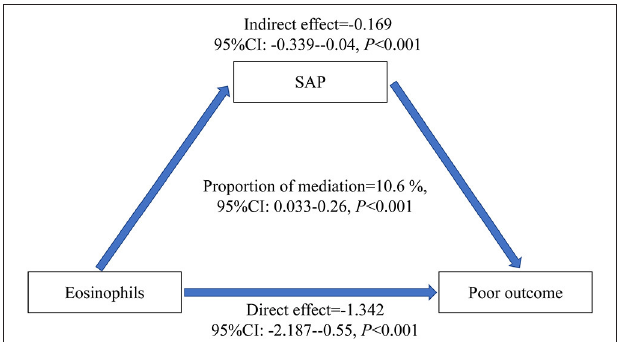
FIGURE 2 | Schematic diagram of mediation analyses for functional outcome. The eosinophils were entered as predictors. SAP was entered as a mediator.